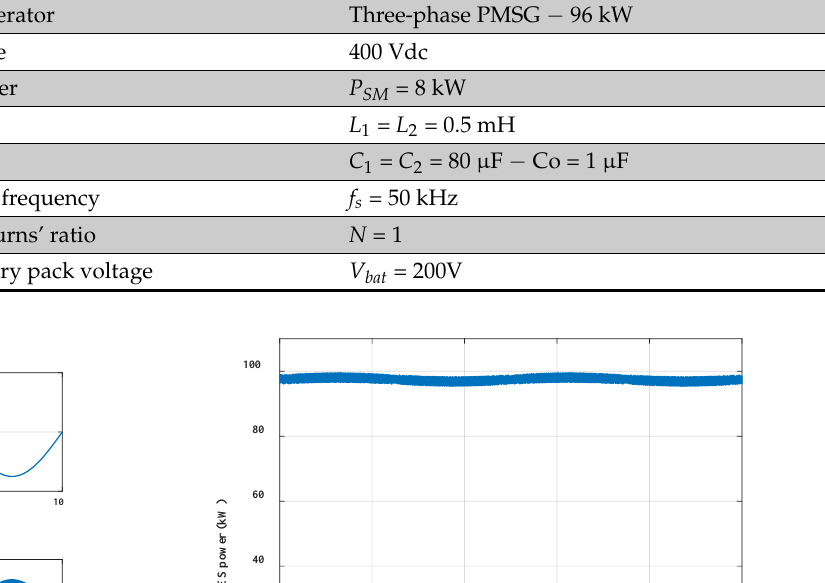
Figure 12. Using SISOTOOL toolbox for tuning the PI controller in Mode 1.